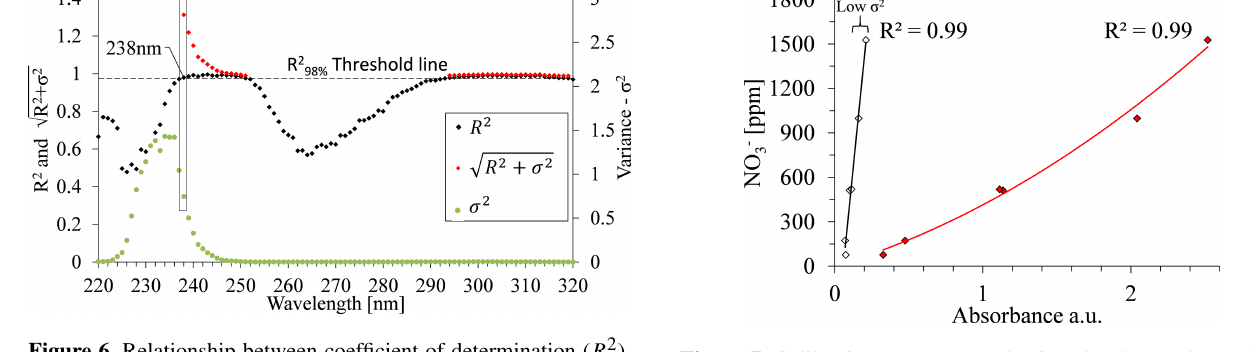
Figure 7. Calibration curves created using absorbance data at 238 and